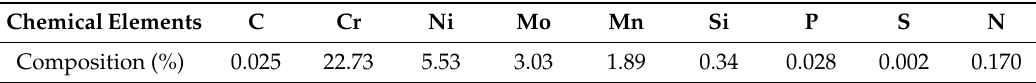
Table 1. Chemical composition of 2205 stainless steel.